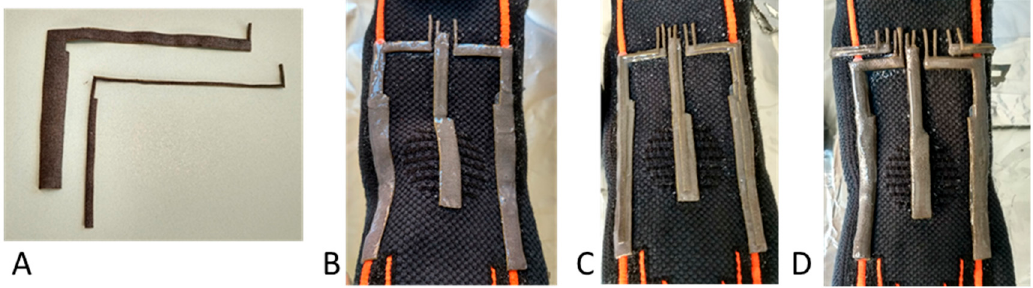
Figure 3. Fabrication process: ( A ) Laser cutting of ground and sensing electrodes. Deposition of: ( B ) Electrolycra bottom ground electrodes and first dielectric layers; ( C ) Central electrodes and second dielectric layers; ( D ) Top ground electrodes and external passivating layers.